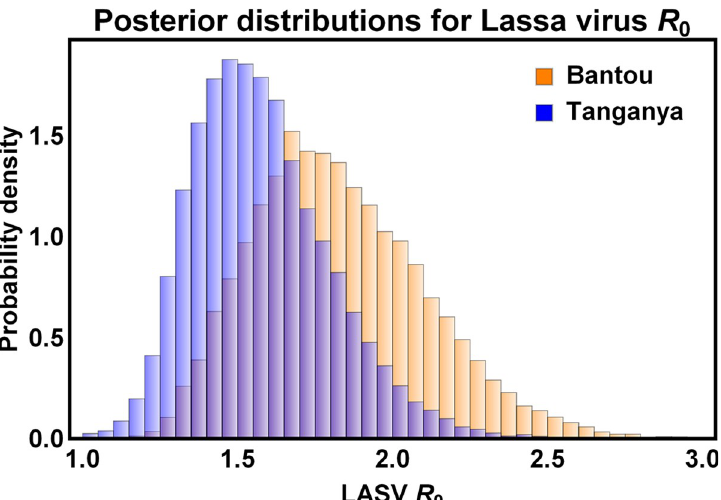
Fig 6. Posterior distributions for the time averaged value of R 0 inferred by our ABC method for the villages of Bantou (orange) and Tanganya (blue). The modal values and credible intervals for R 0 varied somewhat across villages, with modal values of 1.74 and 1.54 and credible intervals of {1.32, 2.32} and {1.17, 1.90} in Bantou and Tanganya,